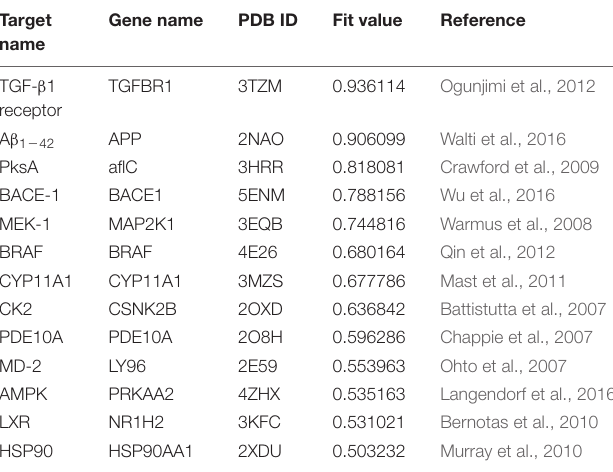
TABLE 1 | Highly potential targets of